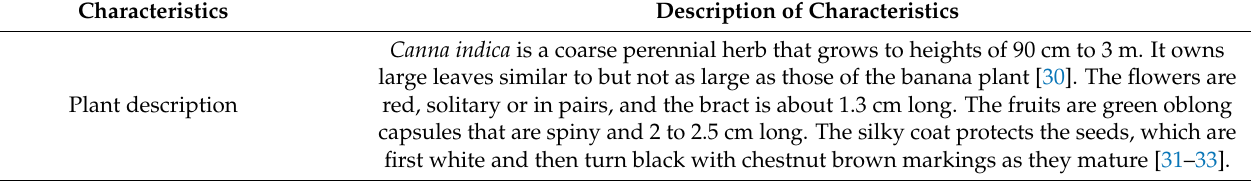
Figure 1. Canna indica plant (Photo by author).